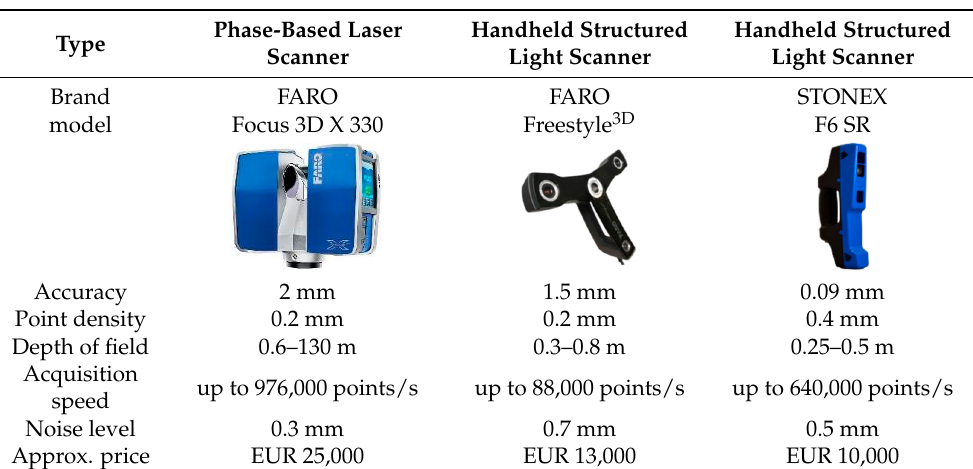
Table 8. Specifications of the employed scanners.